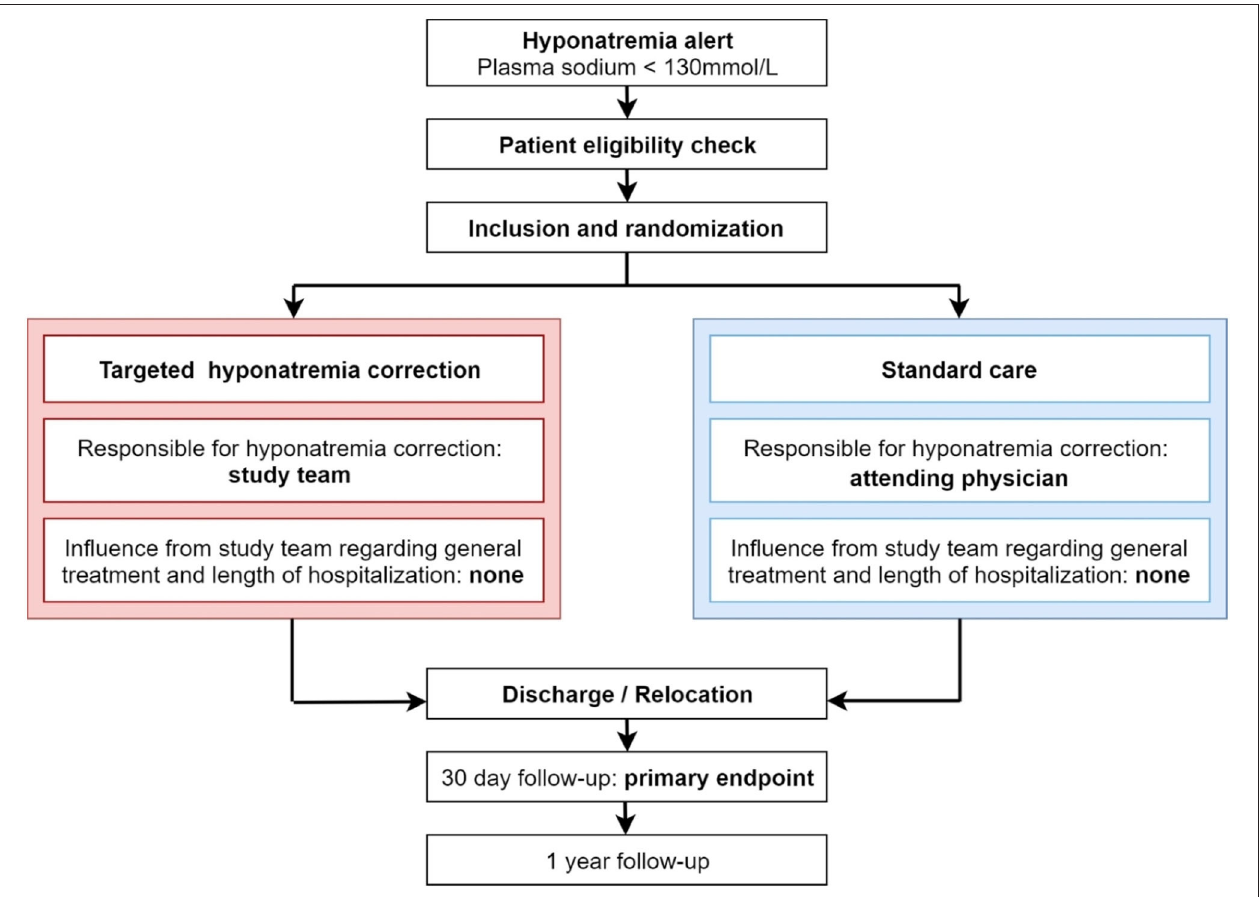
FIGURE 1 | Study design